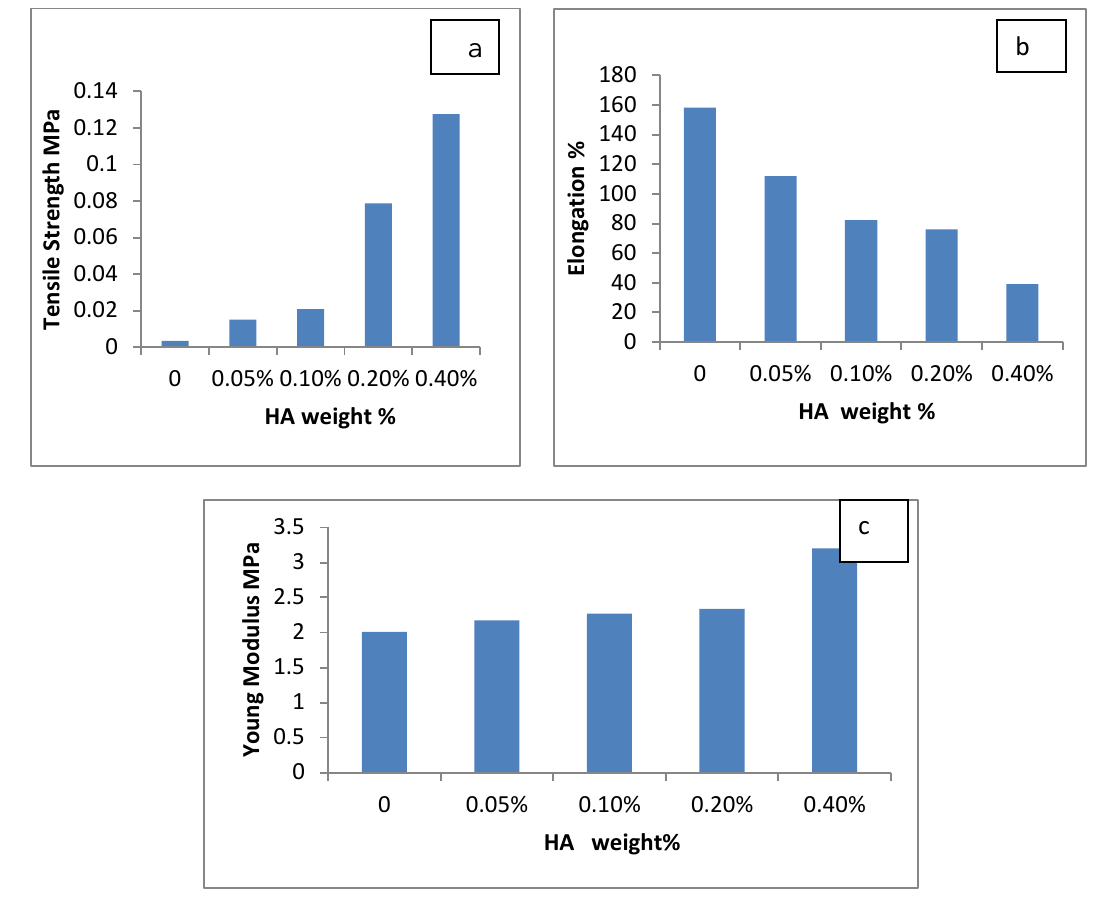
Figure 8: the mechanical properties of pure PCL and (0.05-0.4%) (PCL/HA) composite: a) The Tensile strength, (b) Elongation, and (c) Young